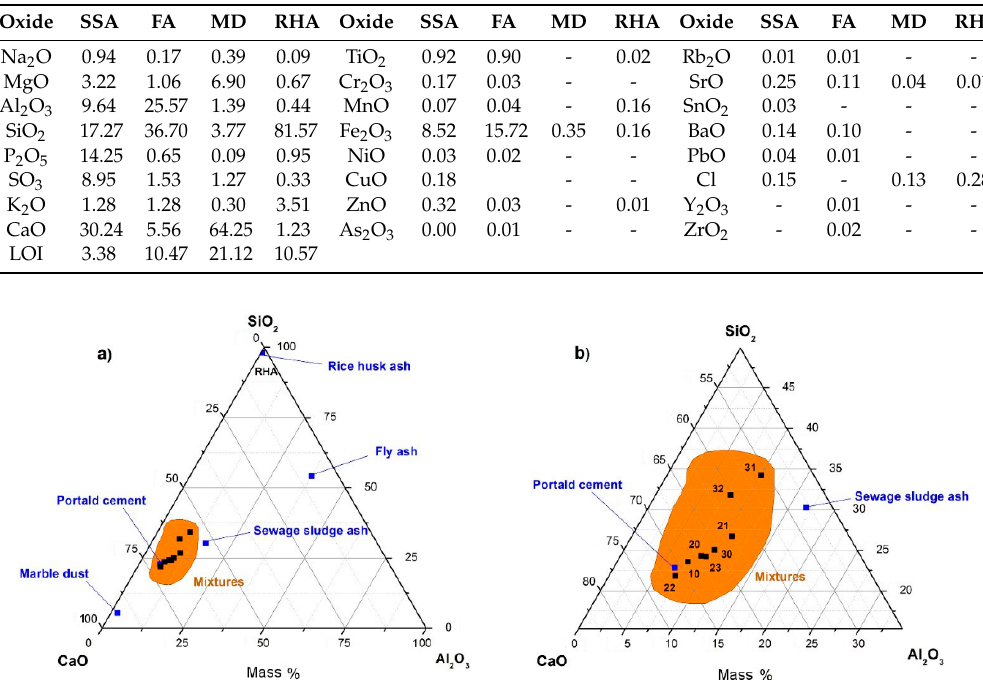
Figure 1. Elemental compositions of the materials used in the study on the SiO 2 -CaO-Al 2 O 3 ternary diagram (based on mass%). ( a ) includes all materials; ( b ) detail of the mixtures, with the following references: 10 (substitution of 10% of the cement by sewage sludge ash (SSA)), 20 (20% SSA), 21 (20% SSA/fly ash (FA)), 22 (20% SSA/marble dust (MD)), 23 (20% MD/FA), 30 (30% SSA), 31 (30% SSA/FA/rice husk ash (RHA)).